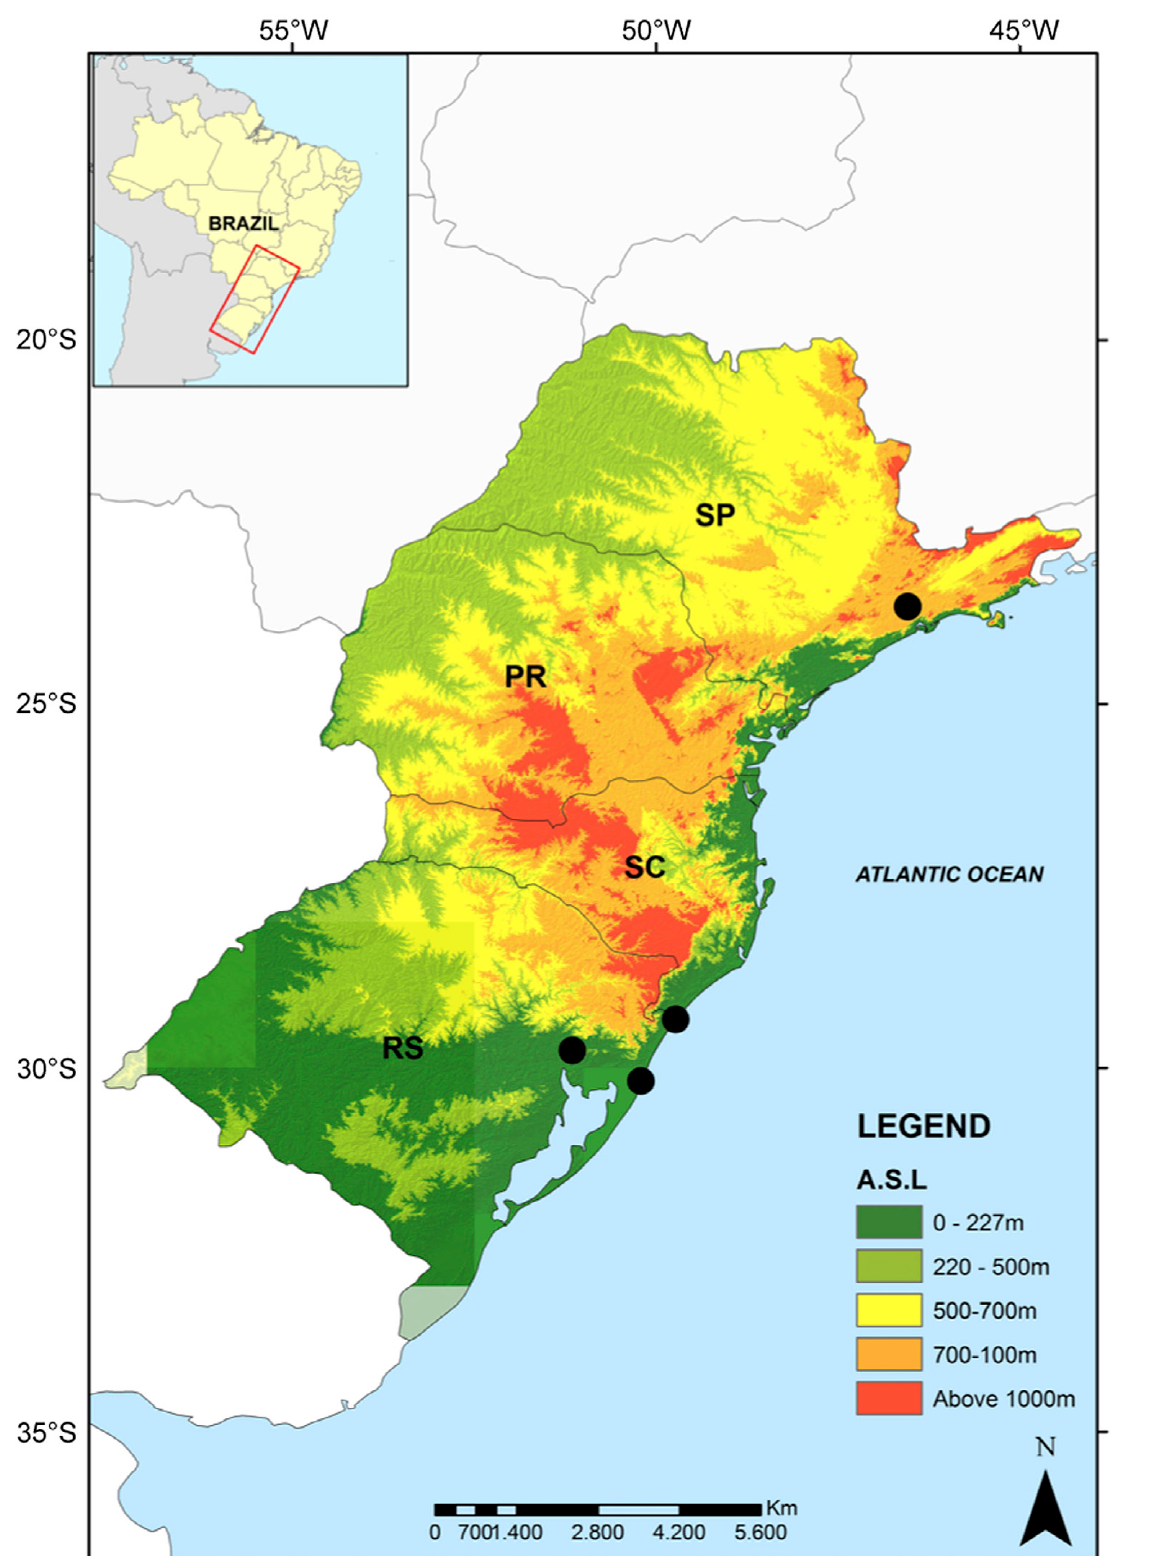
Figure 3. Map of Brazil showing the distribution of Sphagnum squarrosum . Solid black circles: new records. SP = São Paulo State, PR = Paraná State, SC = Santa Catarina State, RS = Rio Grande do Sul State (source: Center for Scientific Computing/JBRJ). unringed elliptic pores on both surfaces (inner and 3 ʹ Leucocysts of branch leaves near base on the inner outer) .......................................................................... 3 surface with large, round pores, and without pores on 3 Leucocysts of branch leaves near base on the inner the outer surface. Canada, Alaska, USA, Greenland, surface without pores and with large pores on the outer Eurasia .............. S. teres (Schimp.) Ångstr. ex surface. Alaska ..........S. mirum Flatberg & Thingsgaar